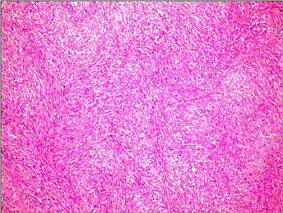
In microscopic appearance of histopathologic analyses, GIST has spindle cell phenotype in a storiform array. Note the compact and highly   cellular pattern, mild-diffuse atypia (H&E, W100).